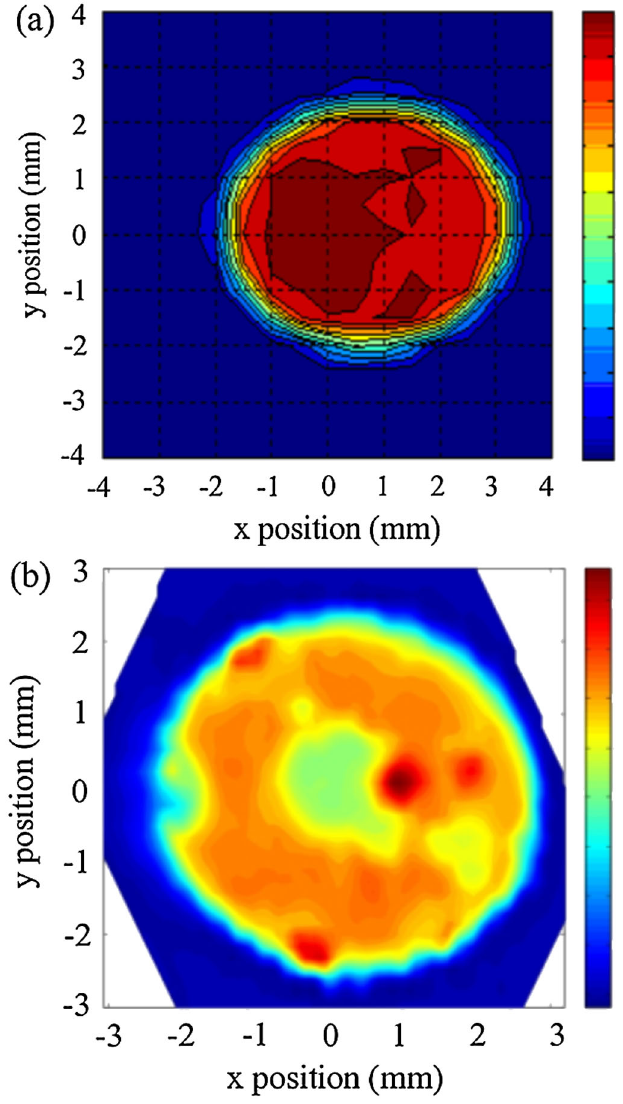
surements).FIG. 11. (Color) Extracted charge as function of laser energy for cathode #90.1 measured at 60 MV = m . Blue circles represent the measured data and the red line shows the linear fit in the low- charge region used to estimate the cathode